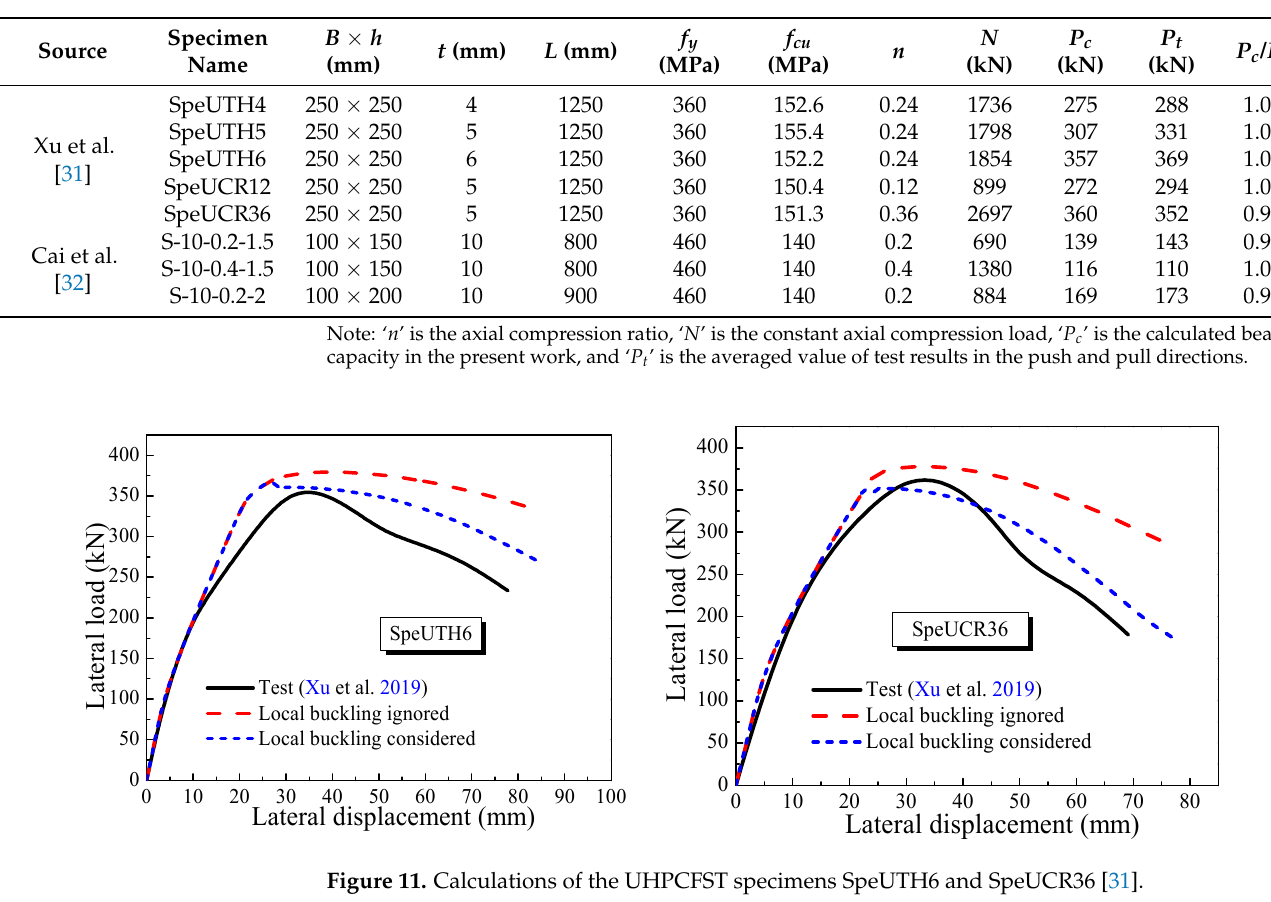
Table 2. Details of the UHPCFST specimens under the cyclic load.